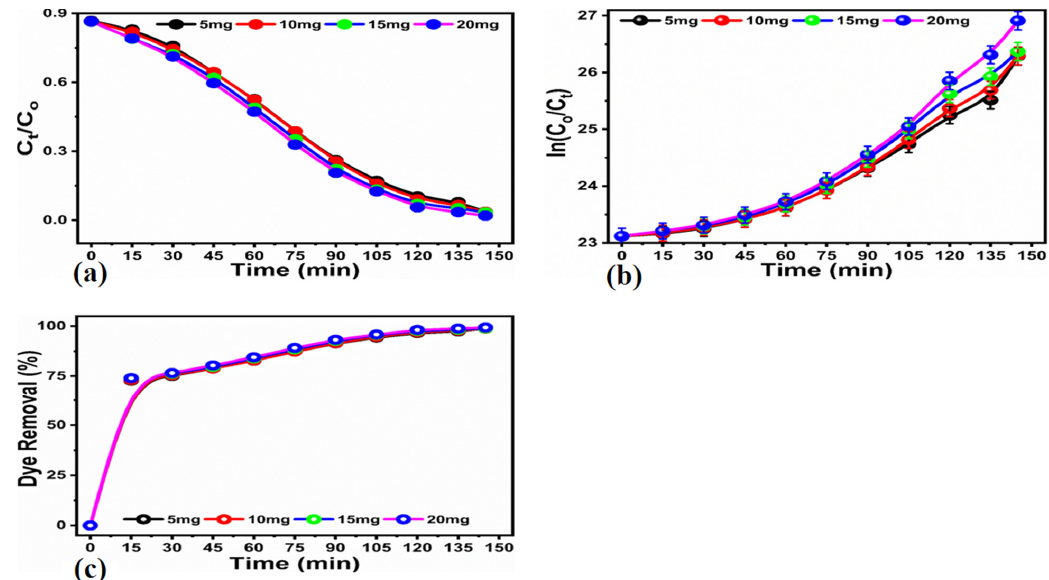
Figure 7. Low concentration absorption spectra under UV irradiation for psyllium-added ZnO with various concentrations of 5 mg ( a ), 10 mg ( b ), 15 mg ( c ), and 20 mg ( d ).